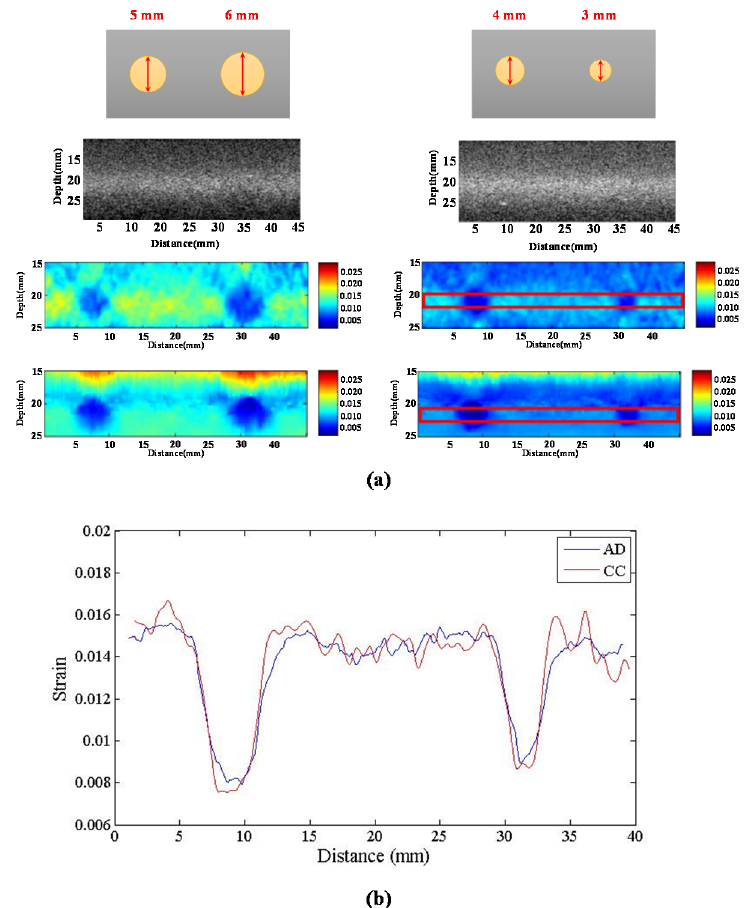
Figure 25. ( a ) Image of strain; and ( b ) curve of strain of strain image at 22 mm of depth.